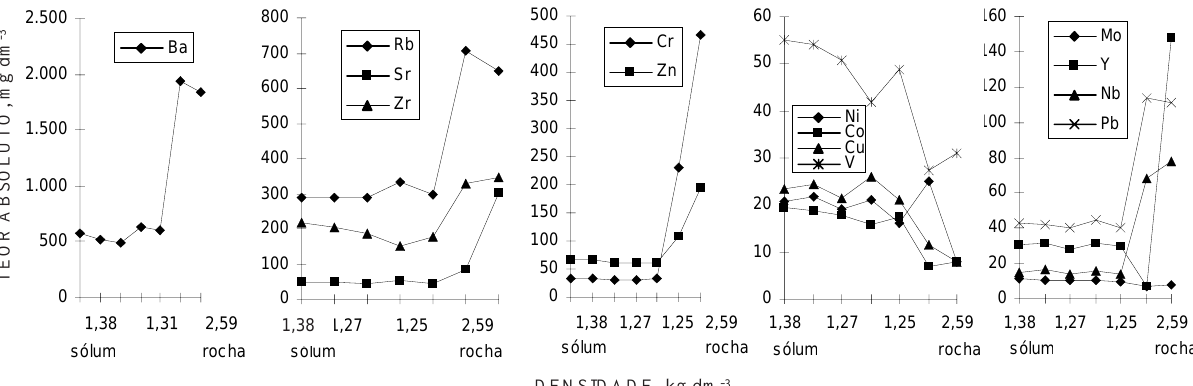
Figura 1. Diagramas de distribuição dos elementos maiores em teores absolutos em função da densidade para o perfil 1 – PVAd.